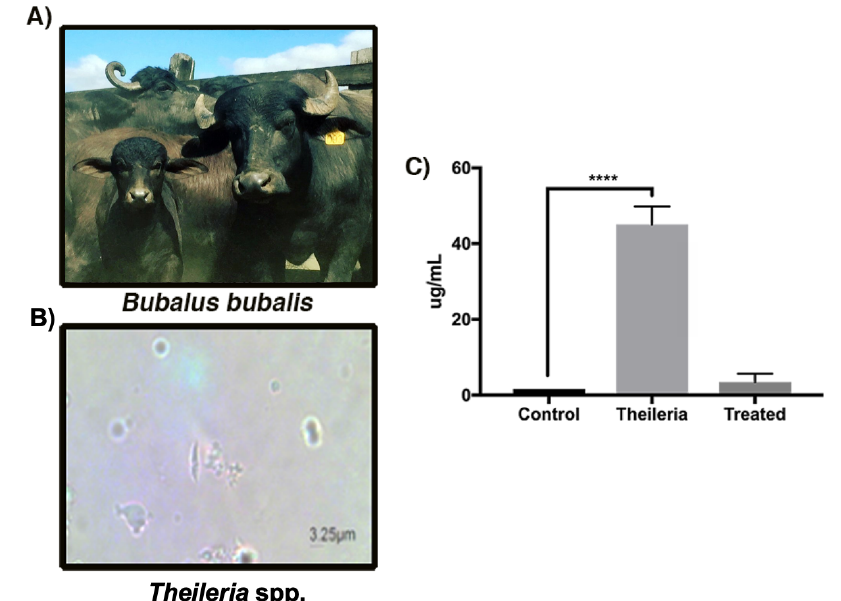
Figure 1. Theileria spp. found in infected animals. (A) Bubalus bubalis buffaloes and (B) photomicrography of the Theileria spp. parasite. (C) DNA quantification showing a reduction of Theileria spp. DNA upon dibenzamidine diacetate treatment.